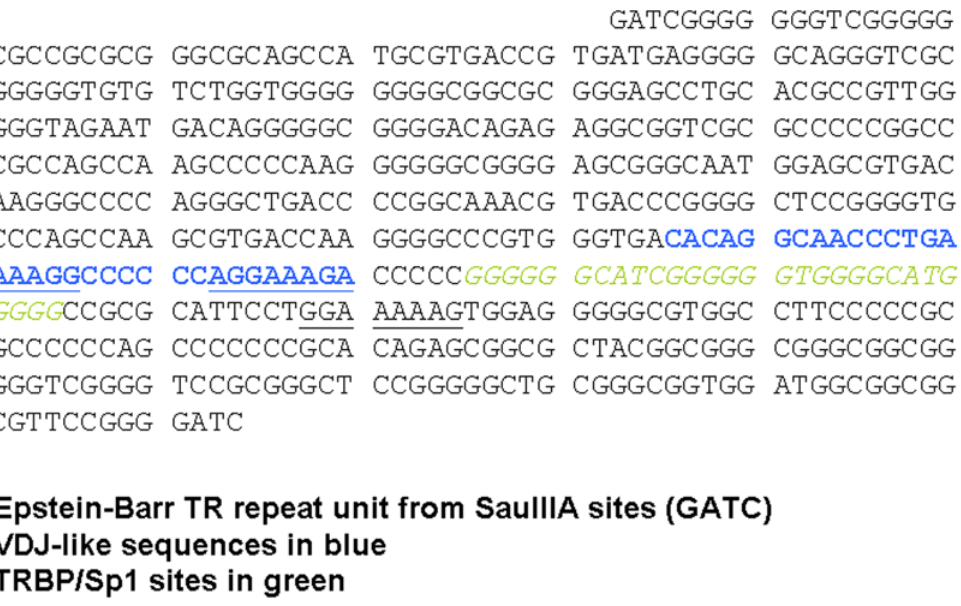
Figure 2. The complete sequence of an EBV terminal repeat defined by the SauIII restriction enzyme is shown with putative V(D)J- like regions and Sp1 transcription factor binding sites identified. Location of V(D)J-like sequences in EBV terminal repeats adjacent to experimentally confirmed Sp1 protein binding sites. Specific protein complexes distinct from Sp1 are also evident on the EBV V(D)J-like sequences shown , and these sequences undergo anomalous migration on native polyacrylamide gels typical of bent DNA similar to the V(D)J RSS and to transposon termini (unpublished observations).